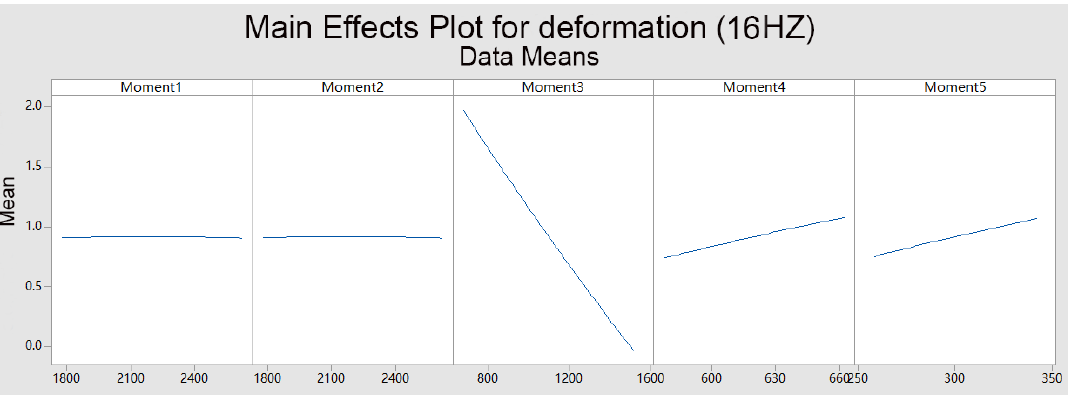
Figure 11. Main effect diagrams of maximum amplitude displacement at the end of a series-parallel controllable mechanisms welding robot.